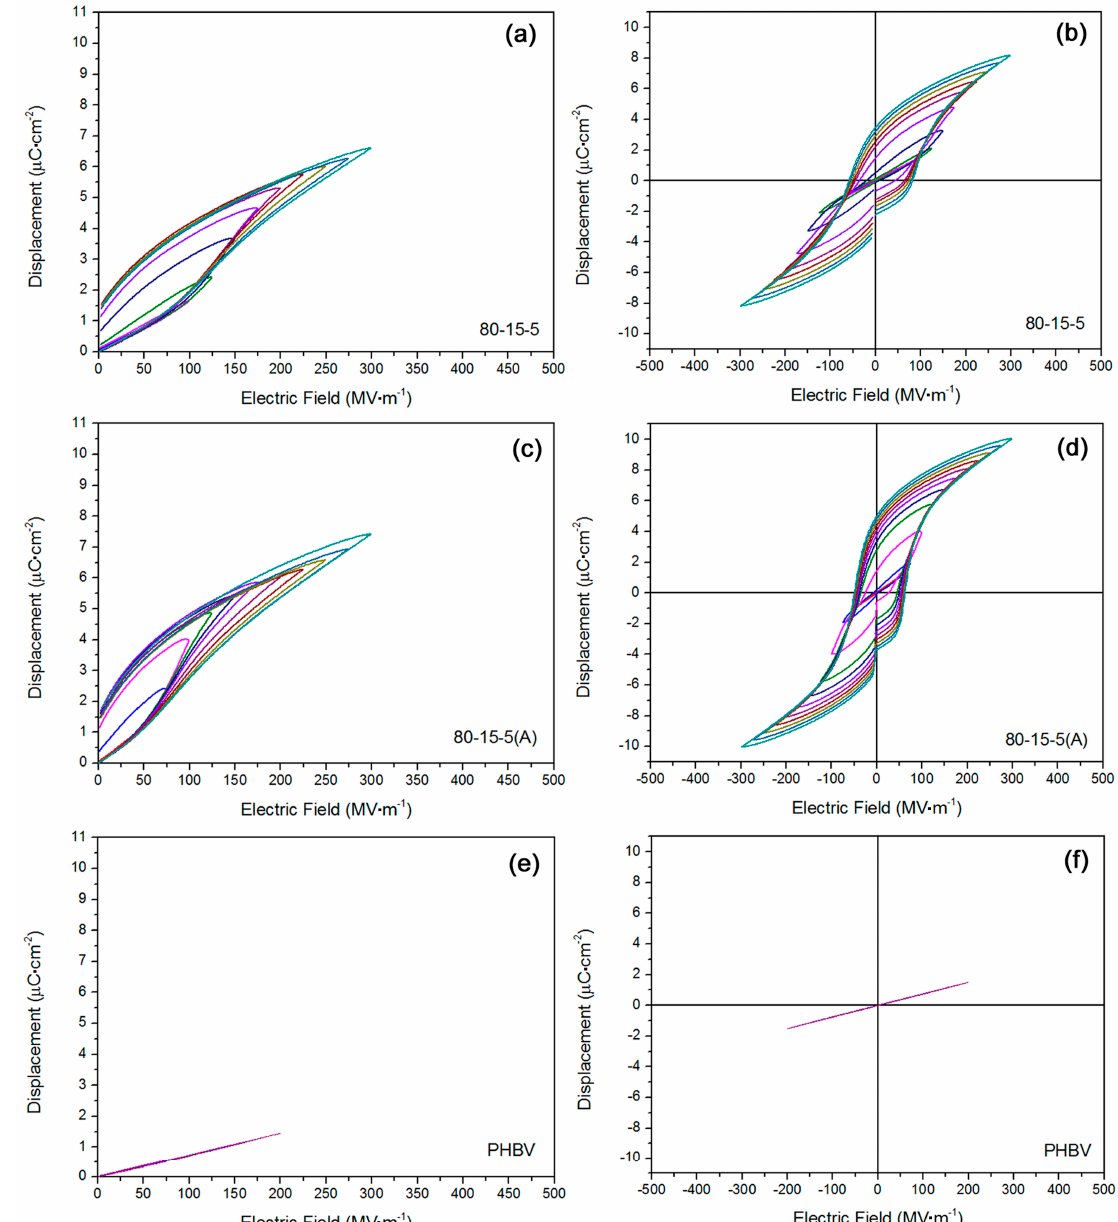
Figure 2. ( a , b ) D - E loops showed the relaxor ferroelectric nature in 80-15-5 sample; ( c , d ) D - E loops exhibited the annealing induced high electric displacement and low coercive electric field for